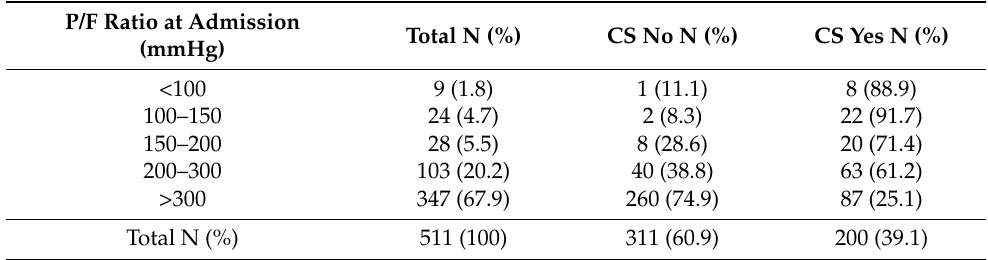
Table 2. Number of patients in the steroid and non-steroid therapy with respect to the ARDS categories.